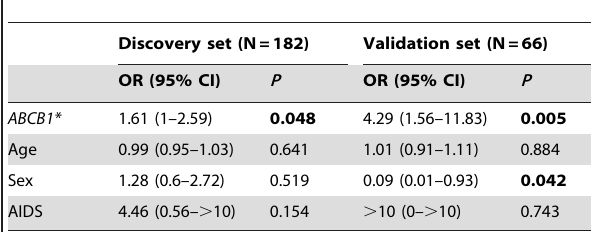
Table 3. Association with increase in CD4 + T cell counts. Table 4. Multivariate